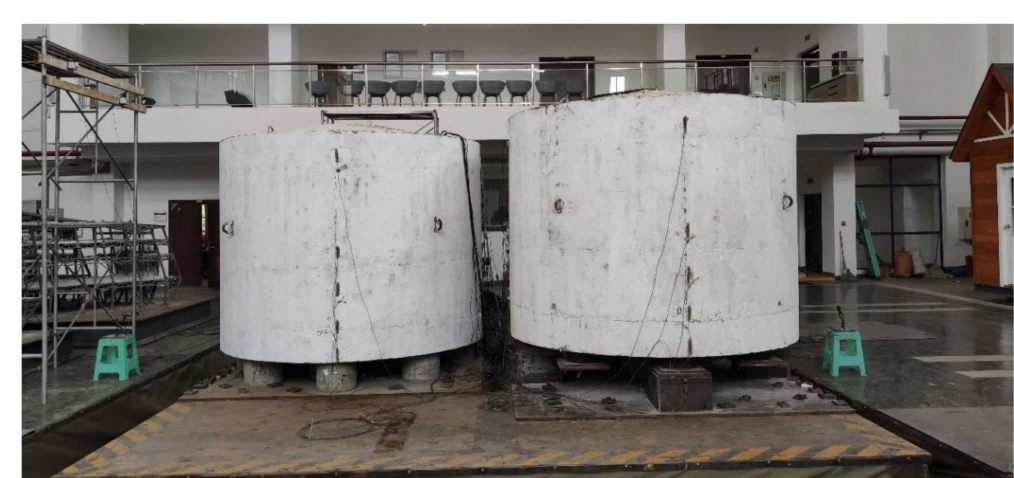
Figure 5. LNG storage tank